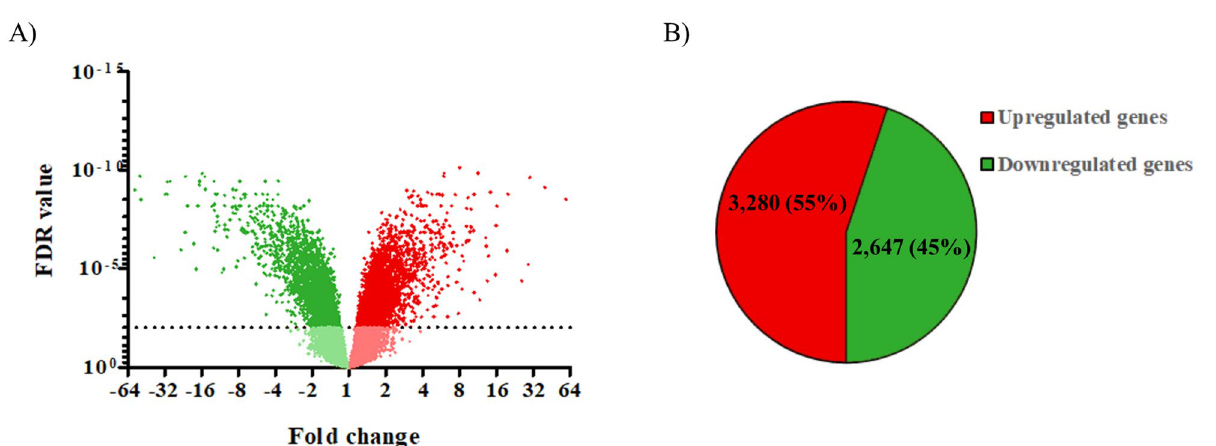
Figure 3. Overview of the differential gene expression in Caco-2 cells grown in a gut-on-chip device versus Transwell inserts after 21 days of culture. ( A ) Volcano plot of all differentially expressed genes where the FDR value of each gene is plotted against the fold change in expression; the dotted line indicates an FDR of 0.01. ( B ) The number and percentages of differentially expressed genes in Caco-2 cells grown in a gut-on-chip device compared to cells grown in Transwell